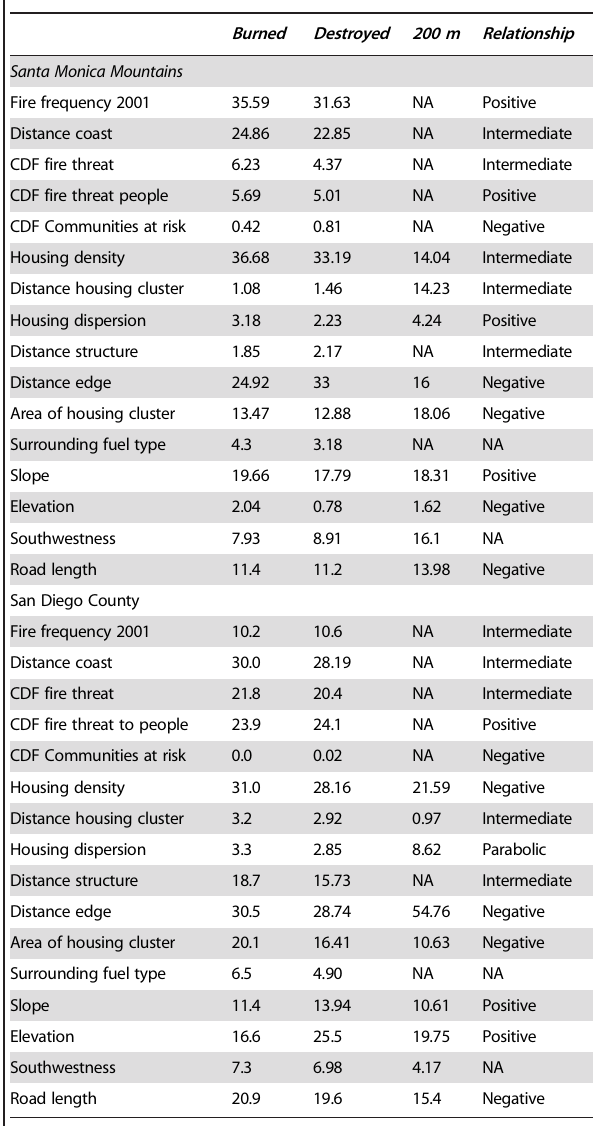
Table 3. Percent deviance explained in generalized additive models (GAMs) for structures that were destroyed or damaged (Burned) and destroyed with the highest certainty (Destroyed); and for burned structures analyzed using a 200 m buffer distance (200